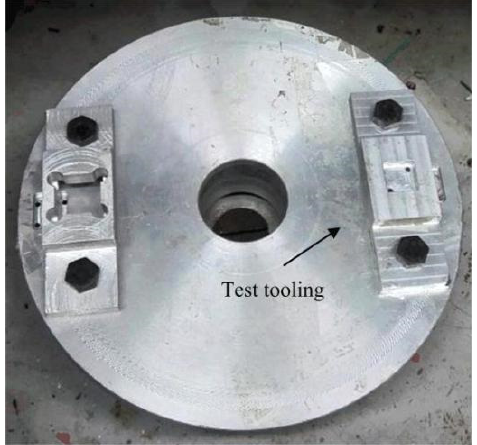
Figure 24. High speed rotating test stand.